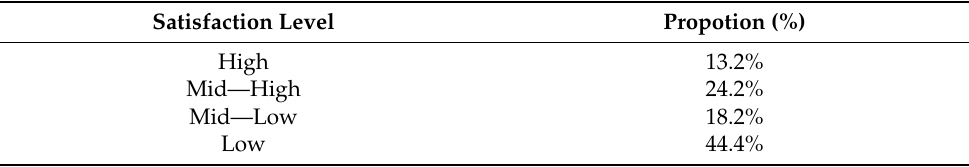
Table 1. Level of perceptions on quality of life—QoL Chile